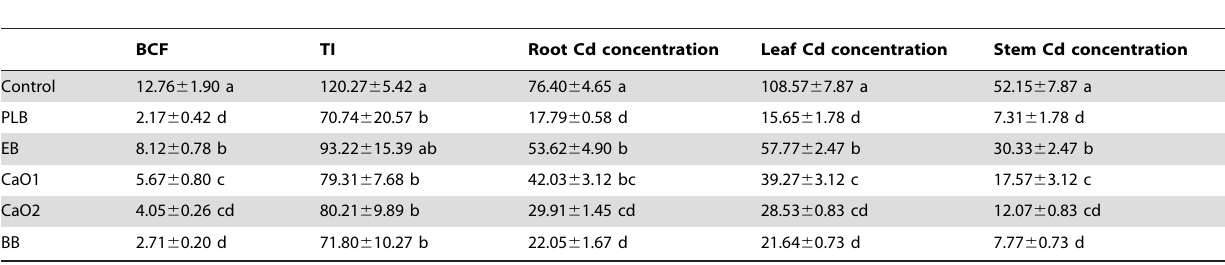
BCF TI Root Cd concentration Leaf Cd concentration Stem Cd